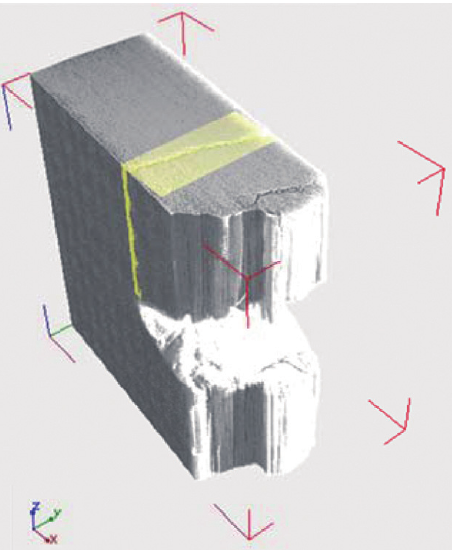
Fig. 15. Specimen 3-D view highlighting the capabilities of the region growing algorithm to isolate the crack